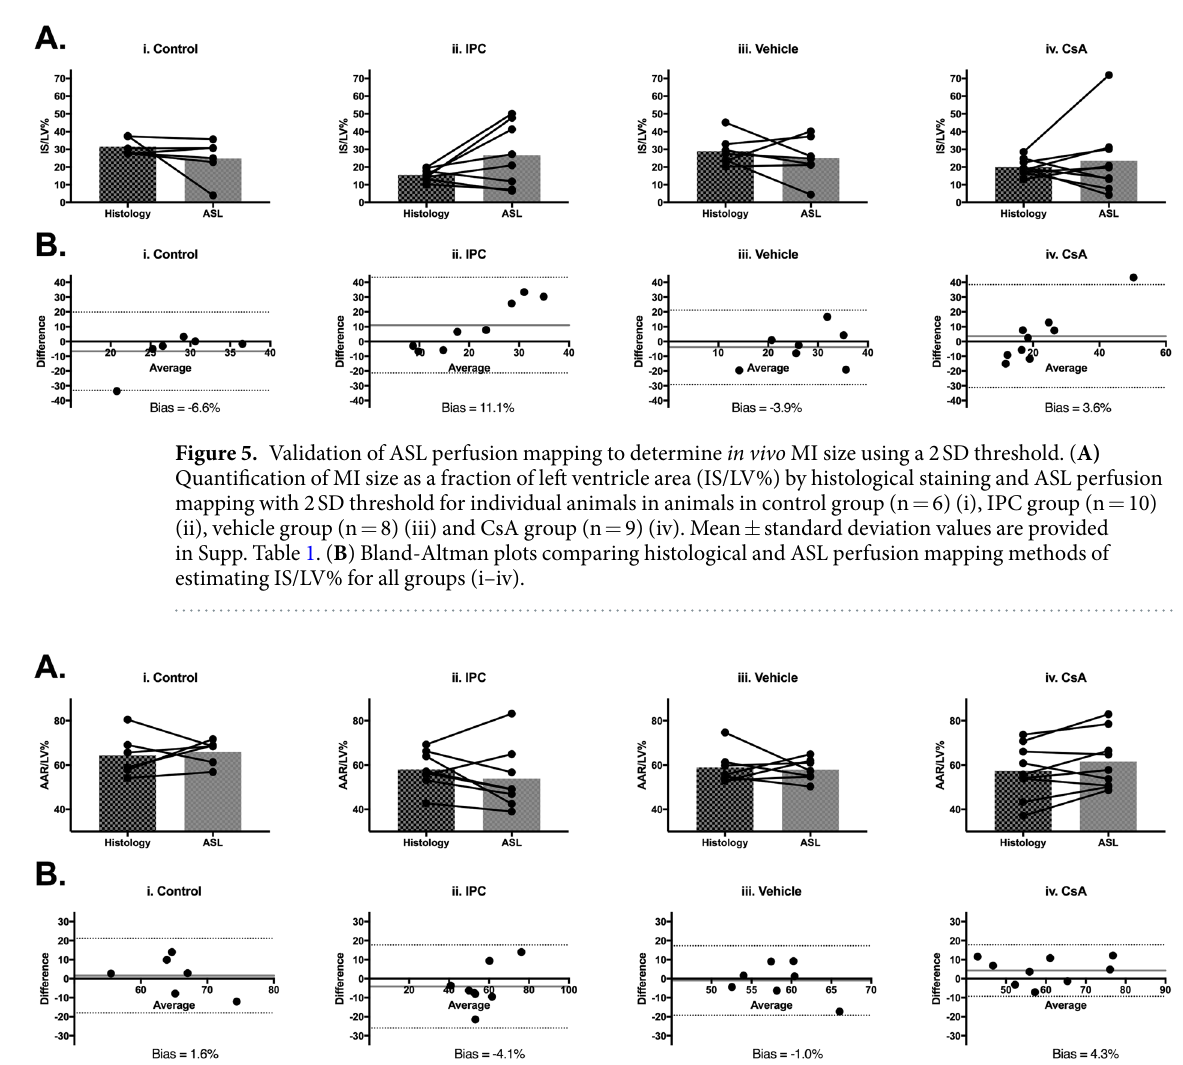
Figure 6. Validation of ASL perfusion mapping to determine in vivo AAR size using a 1 SD threshold. ( A ) Quantification of AAR as a fraction of left ventricle area (AAR/LV%) by histological staining and ASL perfusion mapping with 1 SD threshold for individual animals in animals in control group (n = 6) (i), IPC group (n = 10) (ii), vehicle group (n = 8) (iii) and CsA group (n = 9) (iv). Mean ± standard deviation values are provided in Supp. Table 2. ( B ) Bland-Altman plots comparing histological and ASL perfusion mapping methods of estimating AAR/LV% for all groups